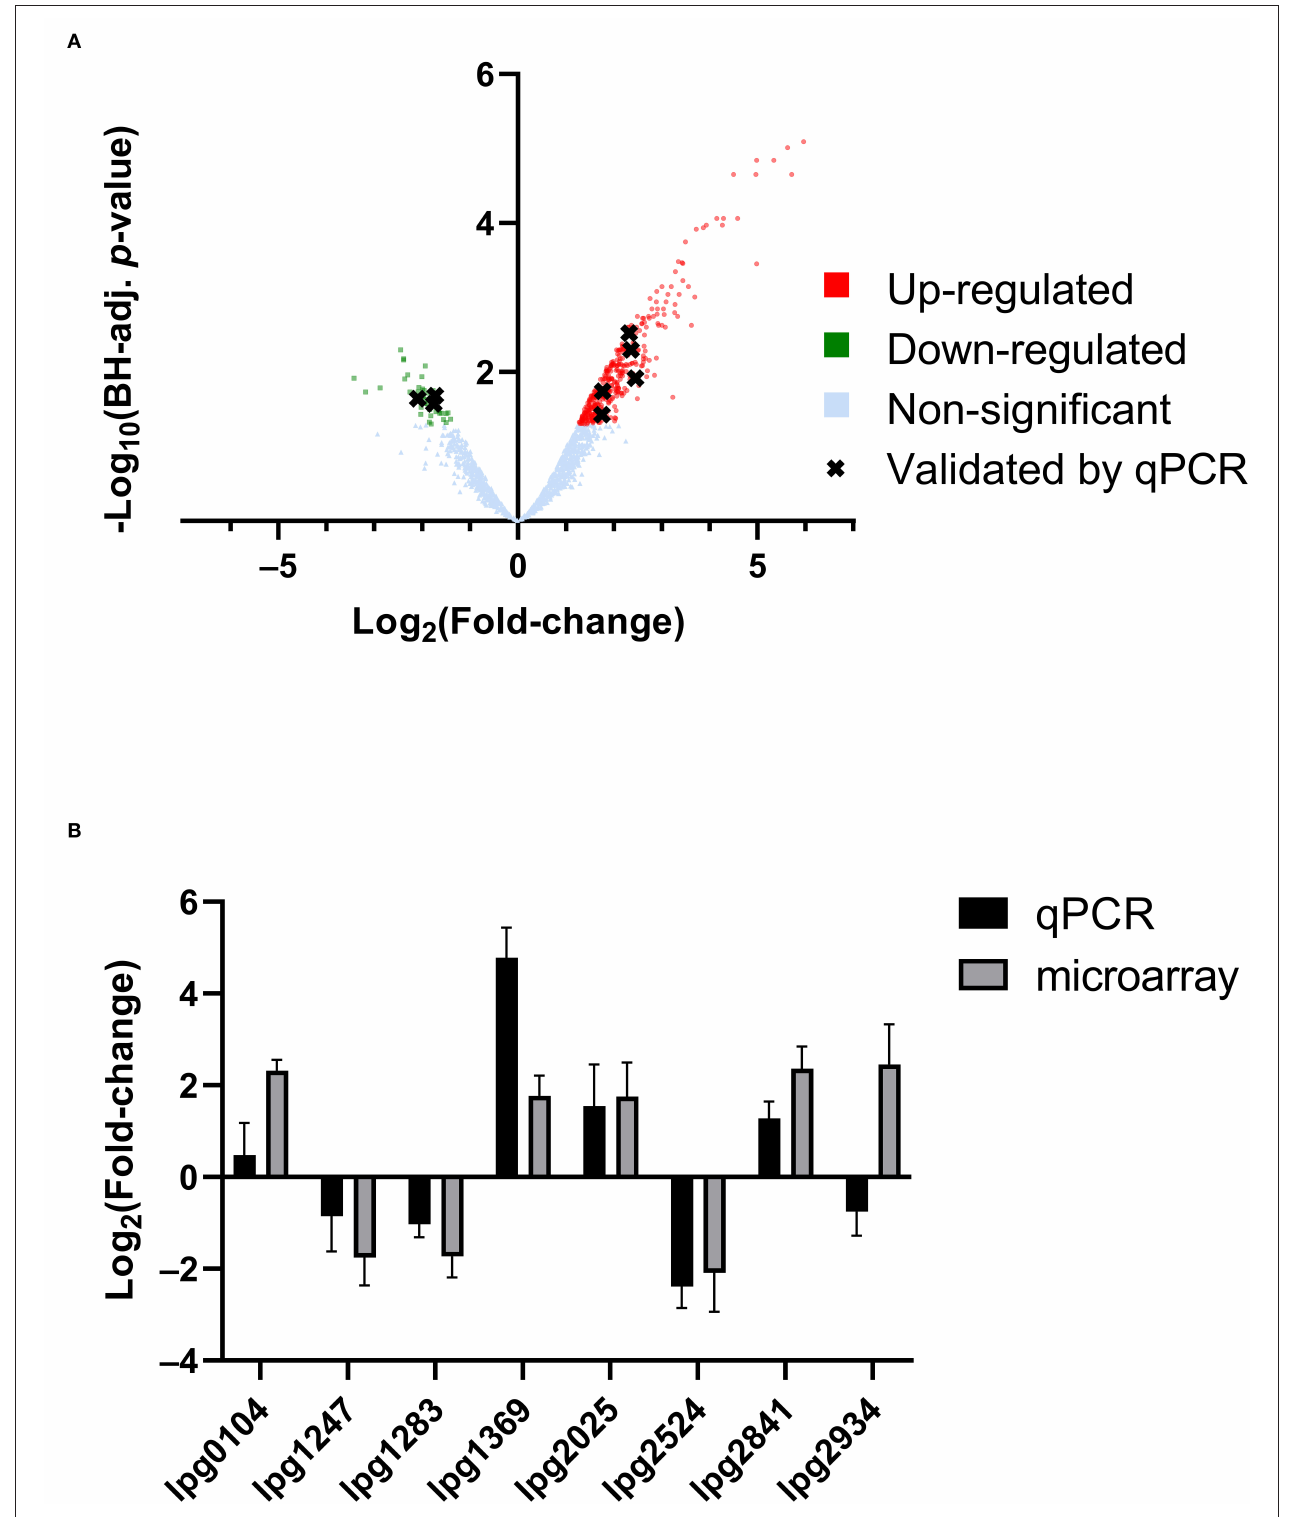
FIGURE 2 | Transcriptomic response of L. pneumophila to heat shock. (A) Volcano plot of microarray data, showing significantly differentially regulated genes. (B) qPCR validation of microarray expression data, showing overall agreement of up-regulation and down-regulation profiles.